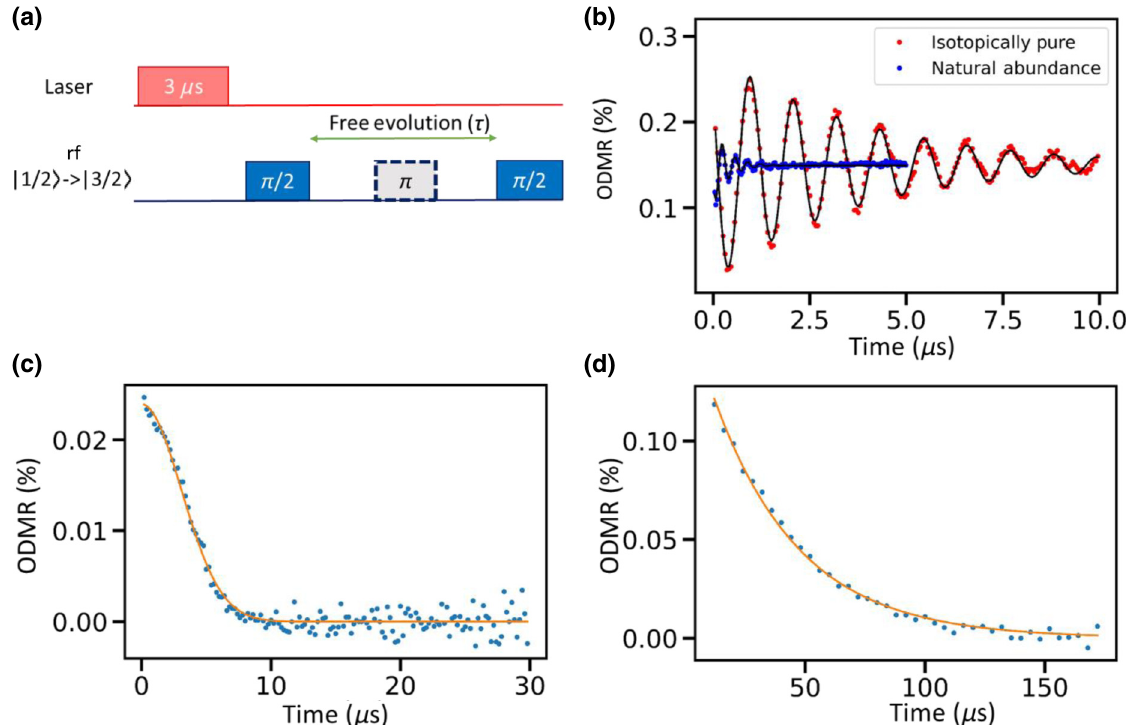
FIG. 3. Ramsey and Hahn echo on the V2 ensemble. (a) Pulse sequence for Ramsey scheme and Hahn echo scheme ( π pulse in dashed box). The π /2 pulse length for the natural abundance sample is 120 ns, while the pulse length for the isopure sample is 400 ns. (b) Ramsey fringe comparison at 11 mT between isopure and natural abundance samples of the same irradiation dose (3 × 10 17 cm − 2 ), of 4 µ s and 400 ns, respectively. Both are fit to A sin(2 π ft + ϕ ) exp( − t / T ∗ ) + B (plotted in black). The signal contrast for the with fit T ∗ 2 2 natural abundance sample is lower due to the far off-resonant drive of the rf pulses. (c) Hahn echo decay of the V2 ensemble (blue dots) in natural abundance sample (3 × 10 18 cm − 2 ) at approximately 4 mT. The T 2 is given as 4.3 µ s from a Gaussian fit A exp[ − ( t / T 2 ) 2 ] (orange line). Unlike the Ramsey interferometry, the Hahn echo of the natural abundance sample is done with the rf near resonance ( π /2 pulse length of 400 ns). (d) Hahn echo of the V2 ensemble in the isopure sample at the same irradiation dose and magnetic field as in (c). T 2 is given as 35.7 µ s from an exponential fit A exp( − t / T 2